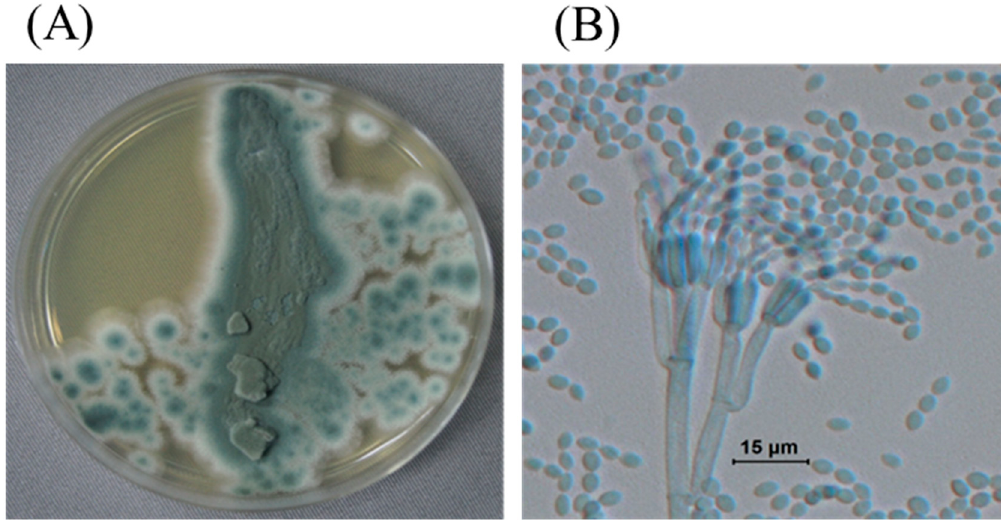
Figure 1. Colony morphology ( A ) and microscopic characteristics ( B ) of metolachlor-degrading strain MET-F-1.